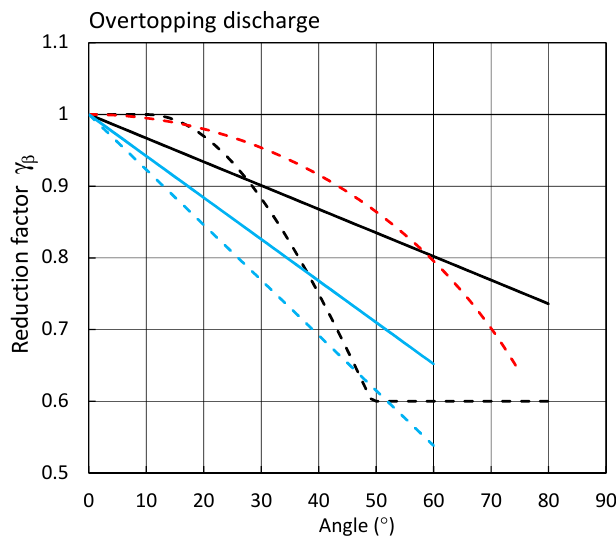
Figure 1. Comparison of methods [16,17,19] describing the influence of oblique waves on wave overtopping (figure based on [20]).